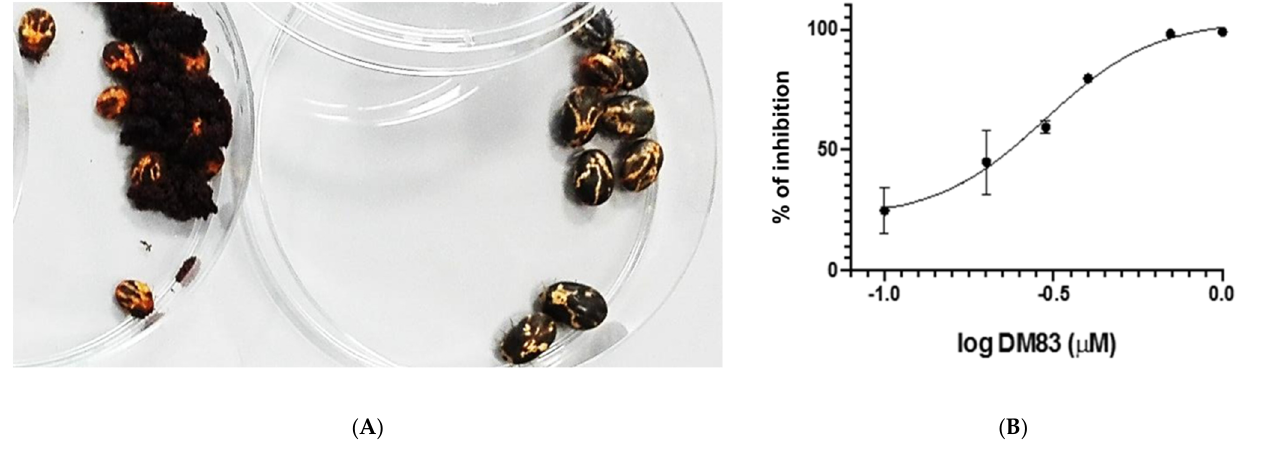
Figure 2. ( A ) Picture showing day 14 of the AIT. To the left, the non-treated ticks and, on the right plaque, ticks treated with 1.5 mM 885 ; in this case, 100% of the ticks were dead. ( B ) Dose–response curve of compound DM83 on the activity of RmTIM. Error bars represent standard deviation and n = 3 for each concentration.